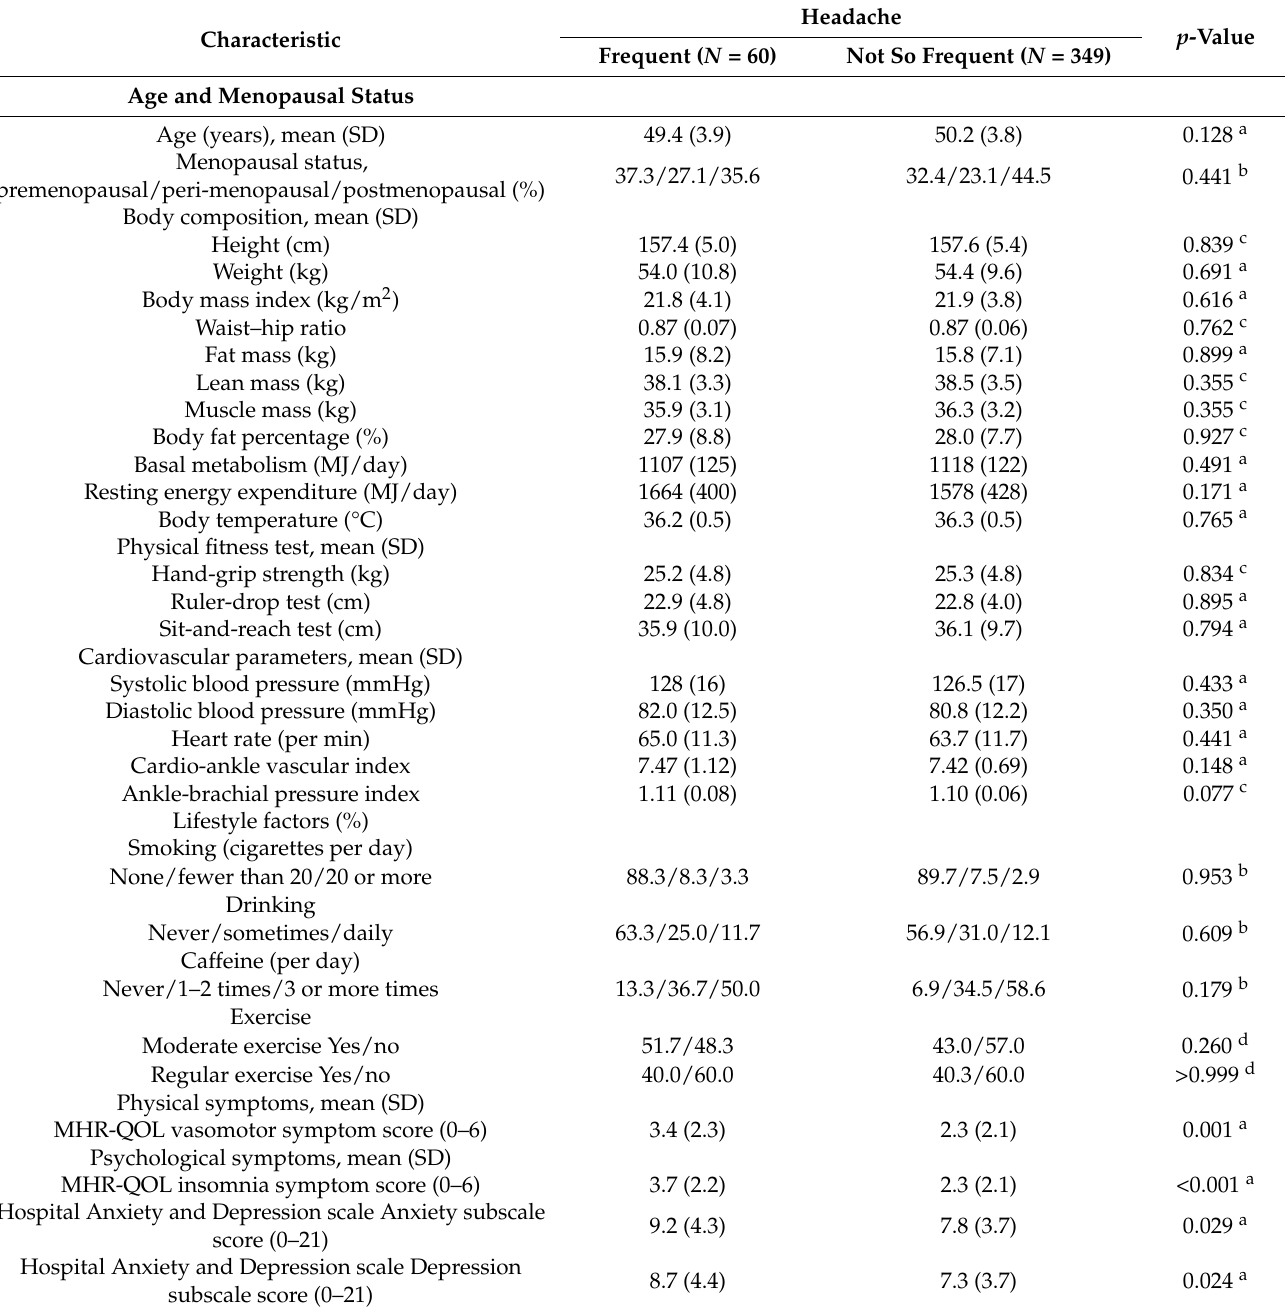
Table 1. Comparison of socio-demographic factors and the frequency of